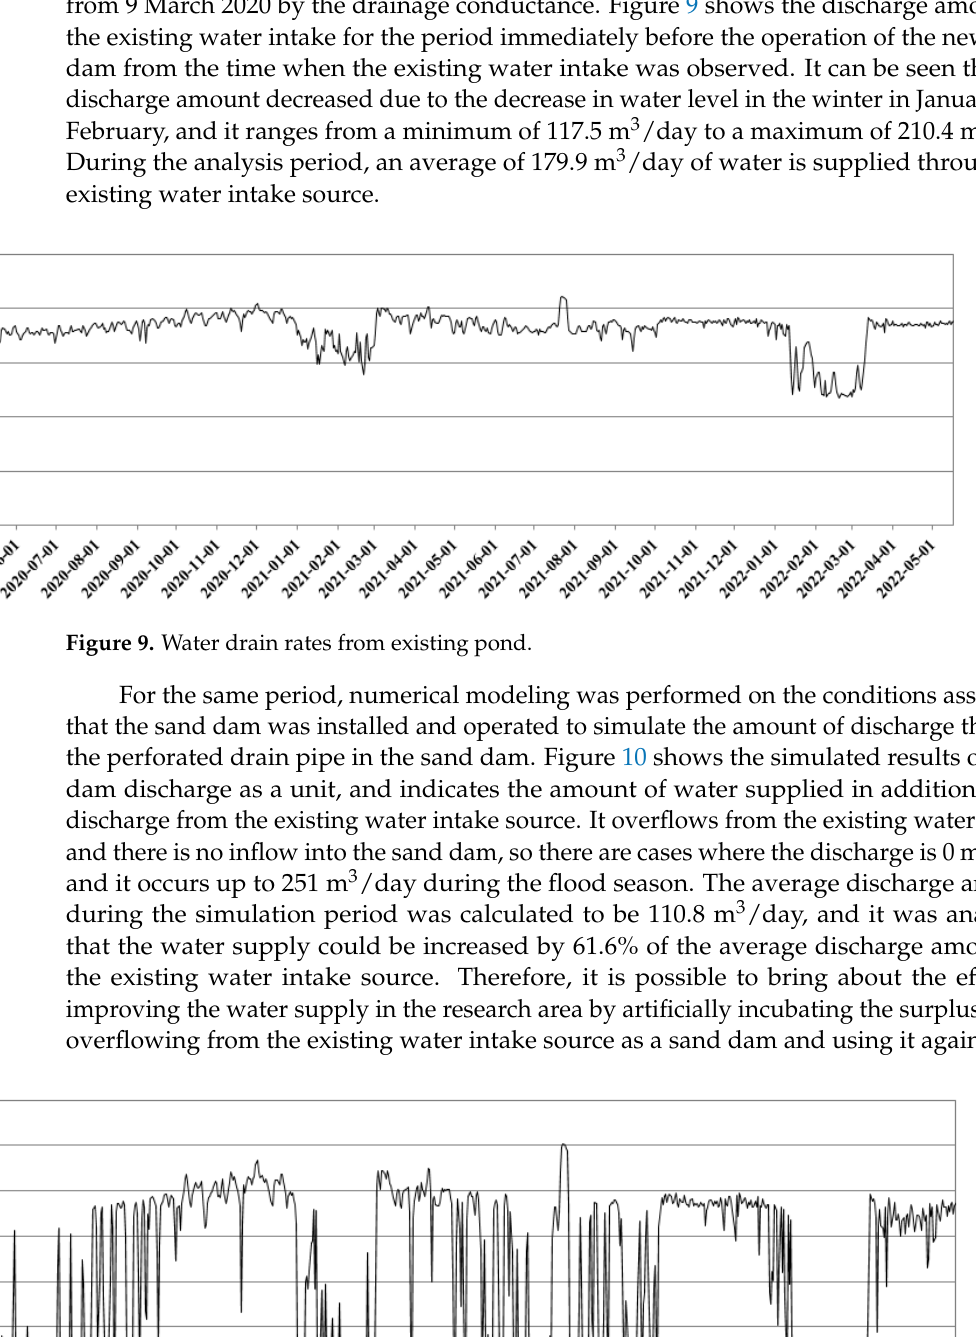
Figure 11. Water drain rates from existing pond and sand dam. The study area suffered from water shortages such as reliance on water trucks due to limited water supply from existing water sources due to an extreme drought in 2016. Therefore, it is necessary to evaluate the water supply capacity when the inflow to the water intake source is very small. For this, the existing water intake source and sand flow were assumed to be reduced by 50% (Case1) and 90% (Case2) compared to the actual in- flow during the simulation period from 9 March 2020 to 16 May 2022. The amount of discharge through the drain pipe of the dam was simulated. Figure 12 shows the simulated drain pipe discharge when the inflow is reduced by 50%. On average, 139.0 m 3 /day from the existing water intake source, 97.8 m 3 /day from the new sand dam, and 236.8 m 3 /day of water discharged from the two facilities, were analyzed to be possible. This is 80% of the average water supply of 290.7 m 3 /day for the actual inflow condition.